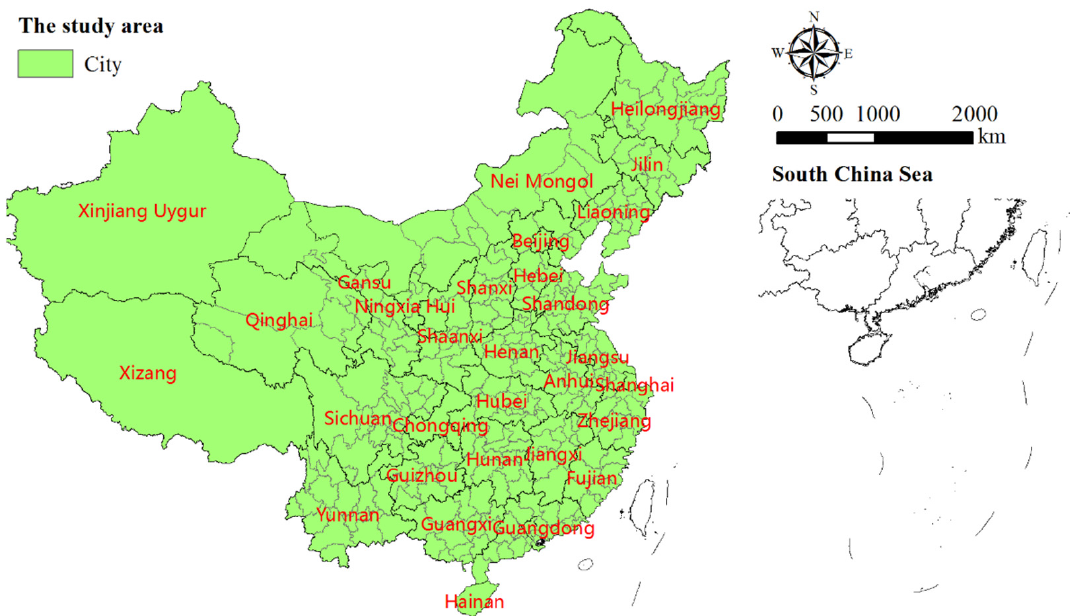
Figure 1. The study area.